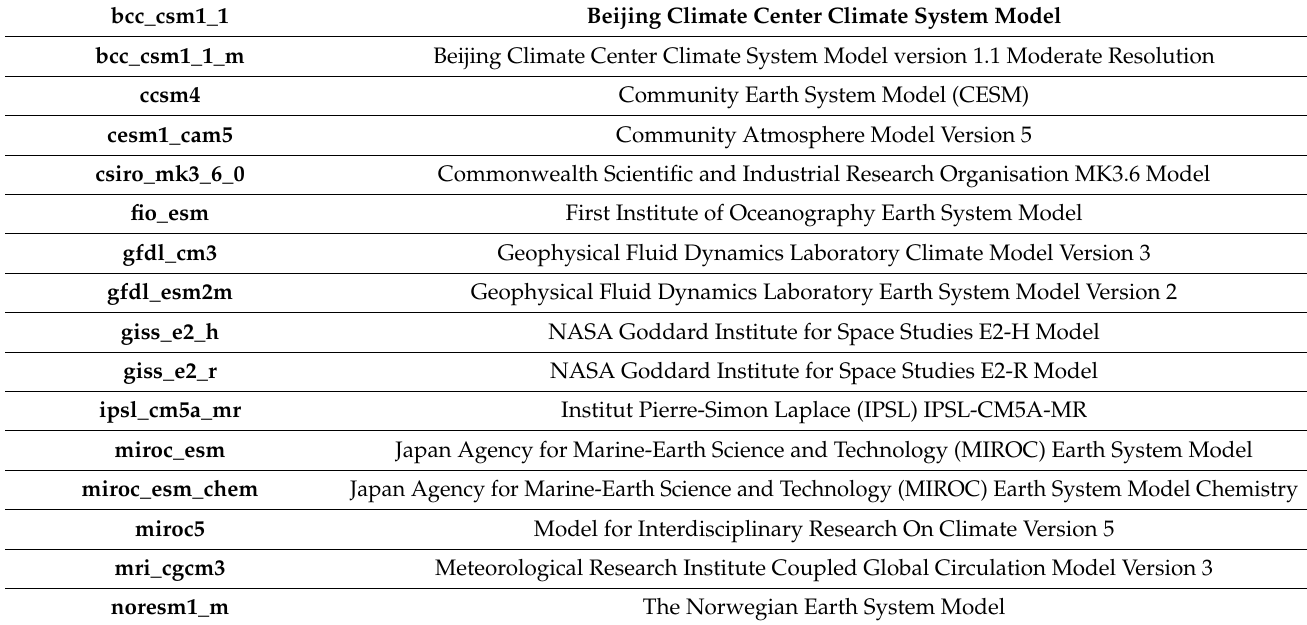
Table A2. CMIP5 GCMs used in assessment.